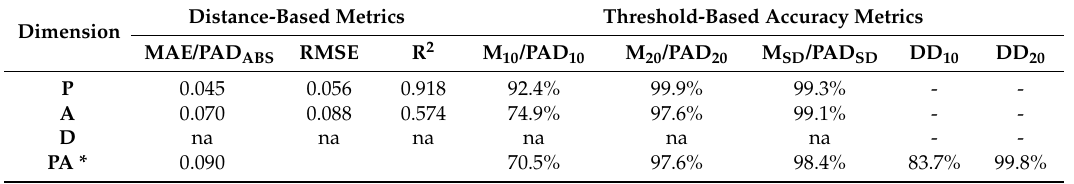
Table 9. Accuracy metrics for the new mapping for the NAWL-NAWL dataset (cross-validation results). Distance-Based Metrics Threshold-Based Accuracy Dimension